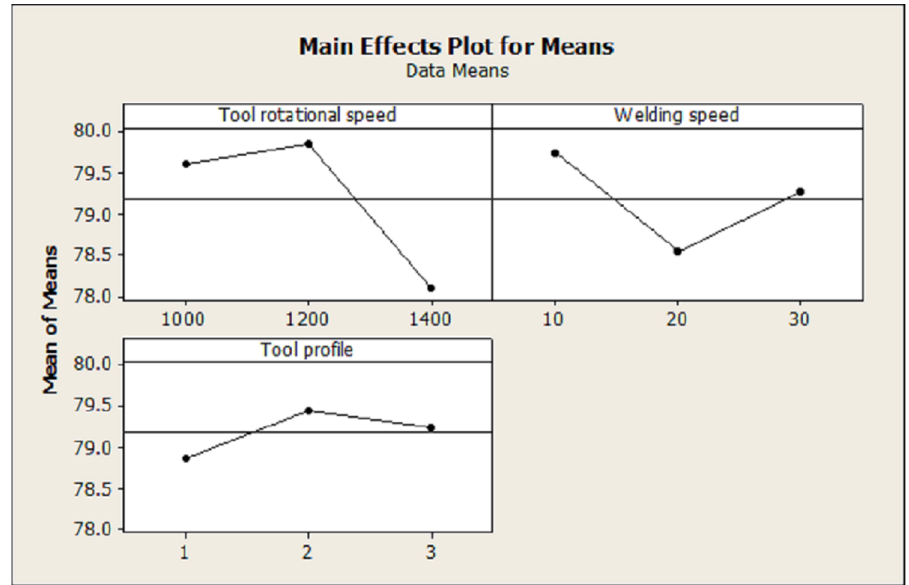
Figure 9. Main effects plot for the means of hardness in the SZ. The main effects plot for the means of the S/N ratio is shown in Figure 10. It was found that the maximum S/N ratio was at a rotational speed of 1200 rpm, a welding speed of 10 mm/min, and with a threaded cylindrical tool pin